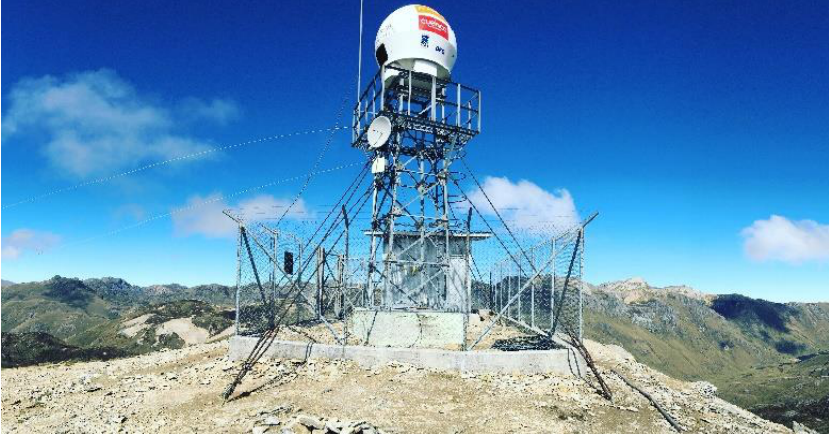
Figure 2. X-band radar station: Radar CAXX Rainscanner-RS120 on Paragüillas peak (4450 m a.s.l).